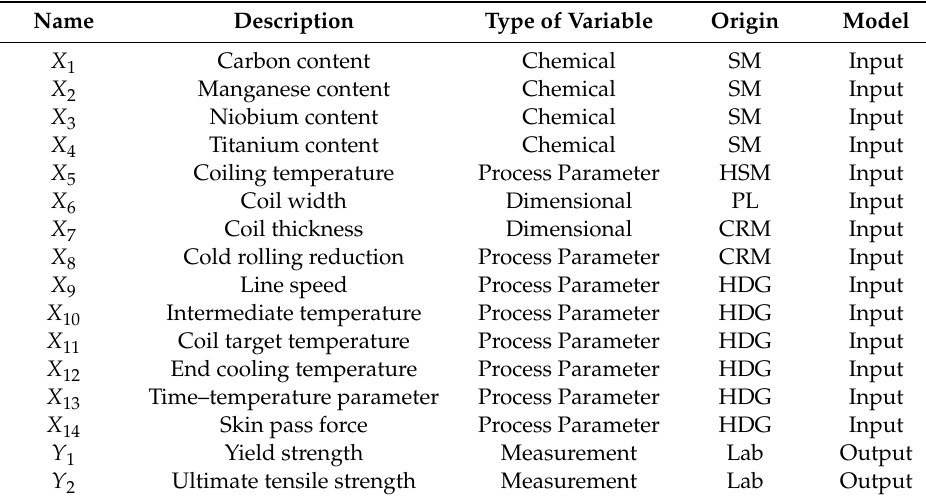
Table 2. List of variables used in the models.